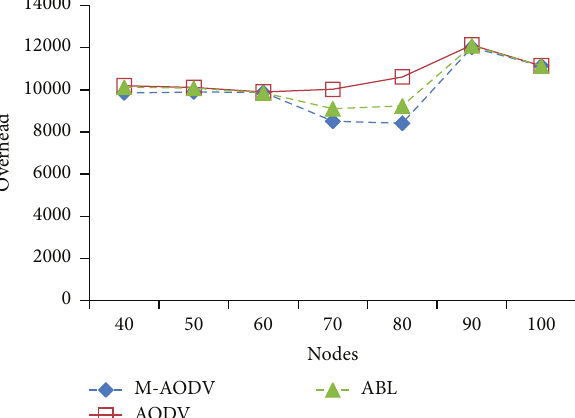
Figure 4: Control overhead in second